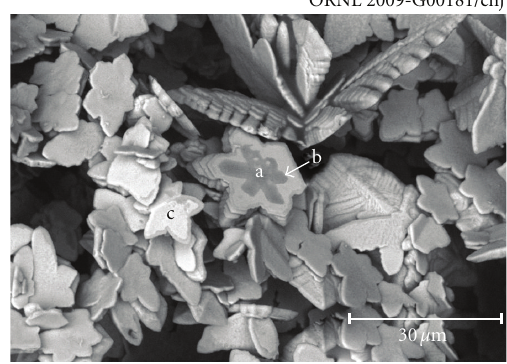
Figure 10: SEM micrograph of primarily metallic Zn crystal structures formed at the surface of a ZnO electrode after elec- trochemical reduction under PEC cell operation for 17 hrs. The darker regions indicate areas with a higher oxygen concentration. The compositional results obtained from an EDS analysis of the indicated regions a, b, and c are shown in Table 2. The hexagonal symmetry of metallic zinc is reflected in the shape of the dendrite- like plates that form in a repetitive layered structure as shown in the